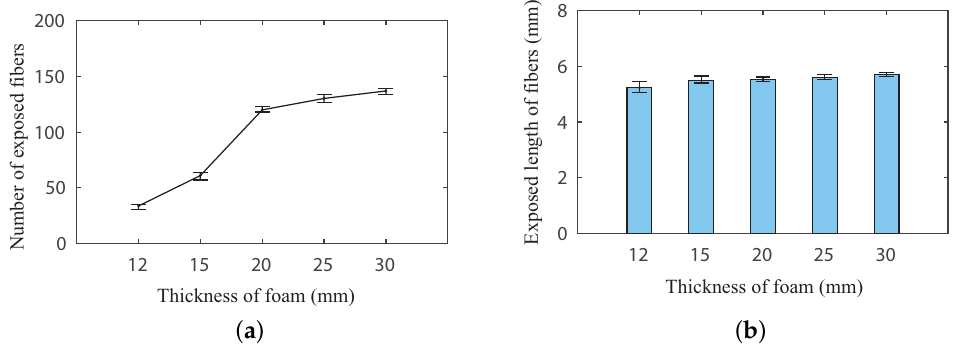
Figure 10. Statistics concerning the exposed fibers with increasing foam thickness: ( a ) Numbers of exposed fibers; ( b ) Exposed length of